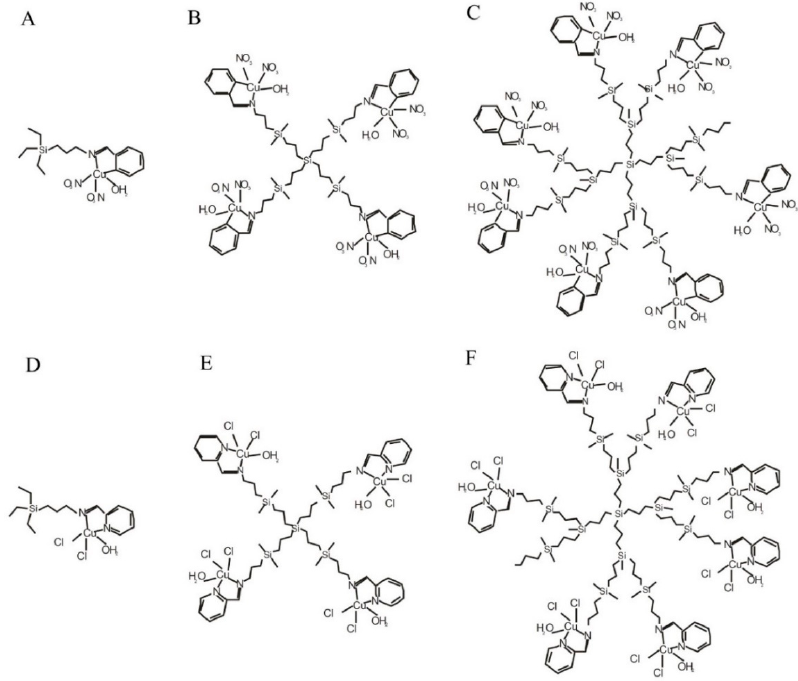
Figure 1. Structure of copper metallodendrimers with the nitrate (A) – CCD-NO-0, (B) – CCD-NO-1, (C) – CCD-NO-2 and chloride (D) – CCD-Cl-0, (E) – CCD-Cl-1, (F) – CCD-Cl-2- surface groups.